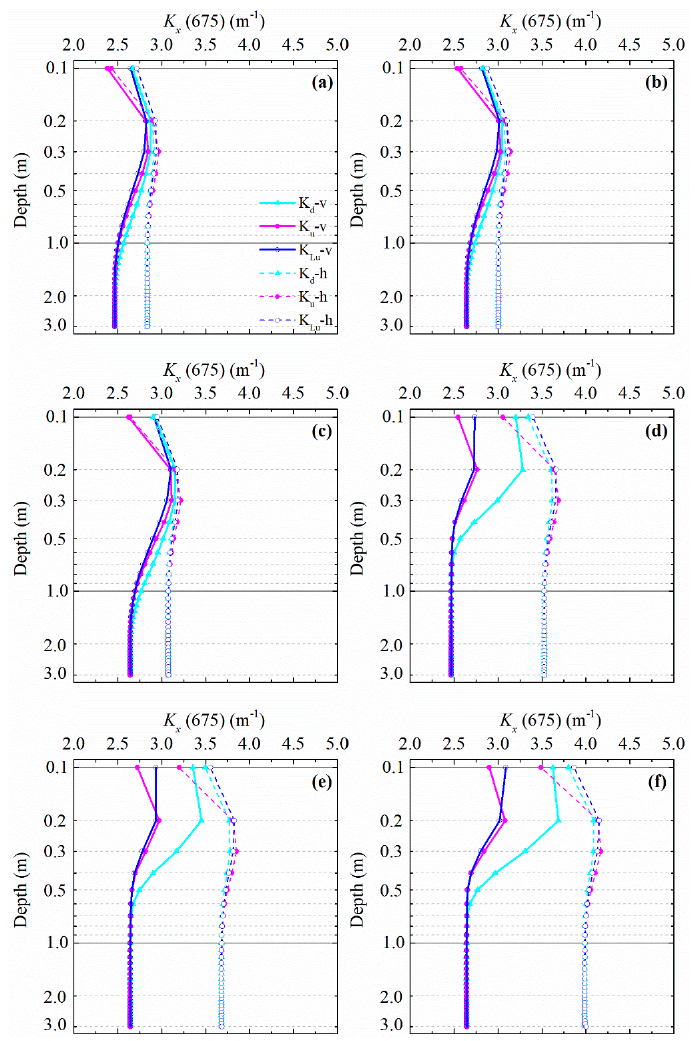
Figure 6. K x (675) vertical profiles under different Chl a (z) distributions: ( a ) L1 (5, 16, 0.6), ( b ) L2 (10, 16, 0.6), ( c ) L3 (10, 21, 0.6), ( d ) L4 (5, 16, 0.2), ( e ) L5 (10, 16, 0.2), and ( f ) L6 (10, 21, 0.2) at 550 nm. K x represents K d , K u , and K Lu . The solid lines represent the K x (675, z) profiles in vertical inhomogeneous waters (“v”); the dashed lines represent the corresponding cases in vertical homogeneous waters (“h”).